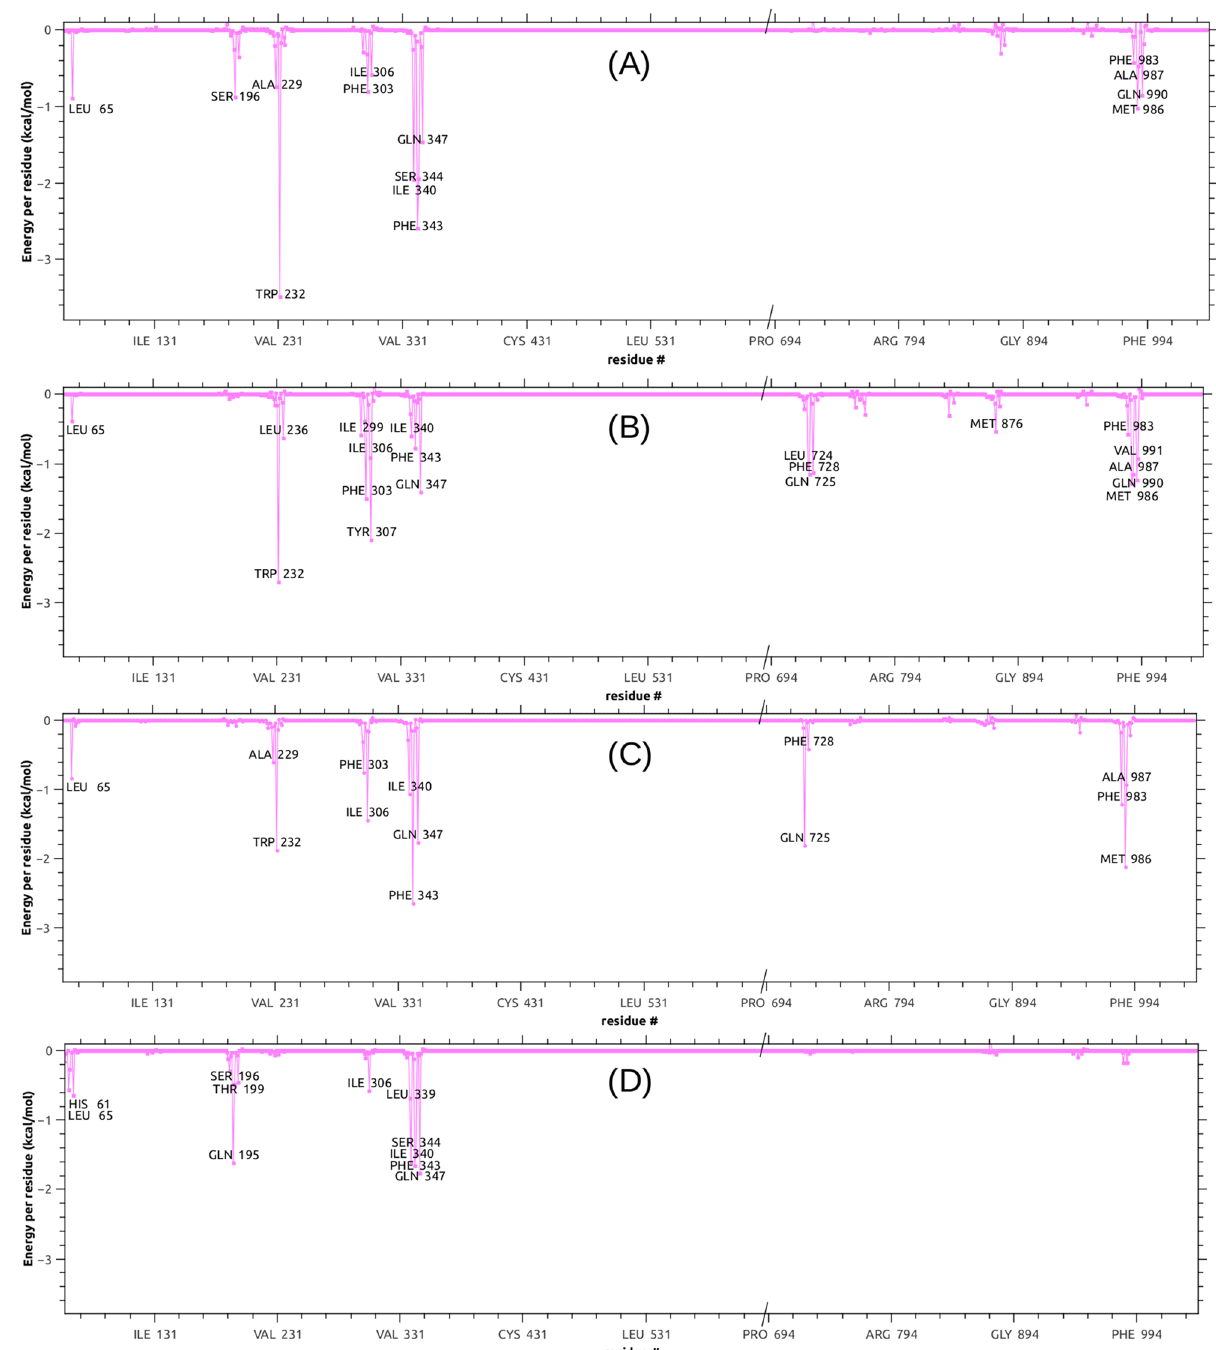
Figure 8. Decomposition of the MD free energy of binding in terms of per residue contribution. Residues showing the most negative peaks correspond to stronger stabilizations: ( A ) doxorubicin; ( B ) tariquidar; ( C ) compound 5c , ( D ) compound 5